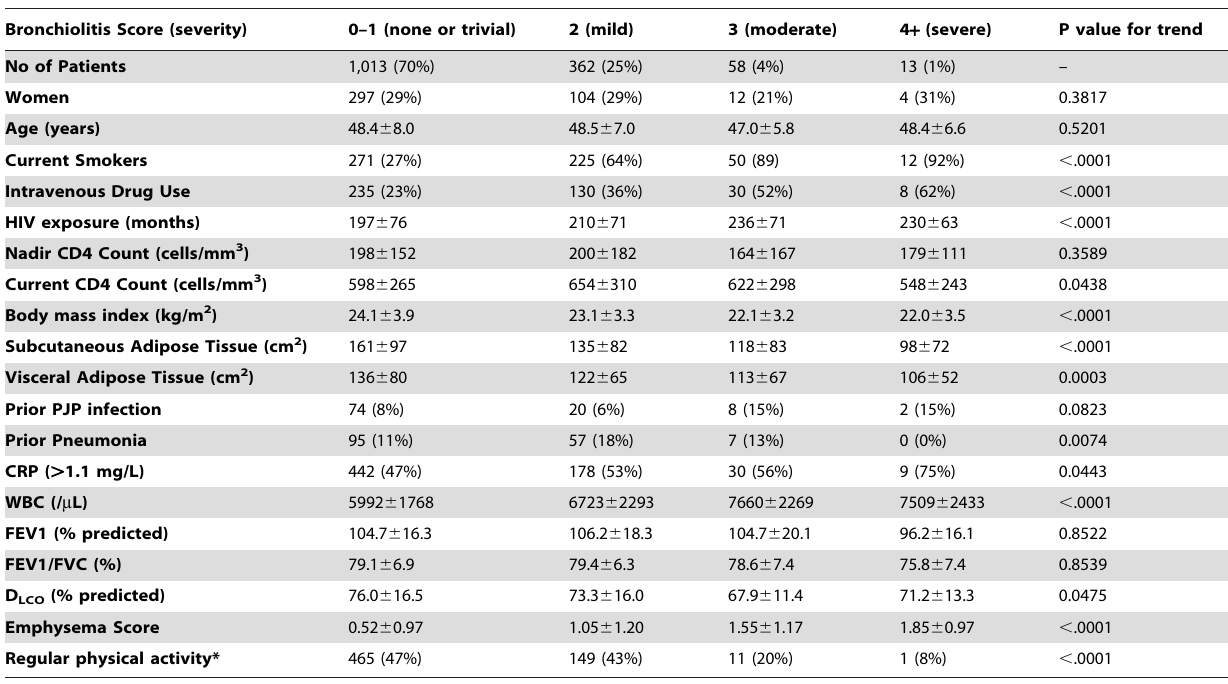
Table 3. Clinical Risk Factors and Health Outcomes for Bronchiolitis.